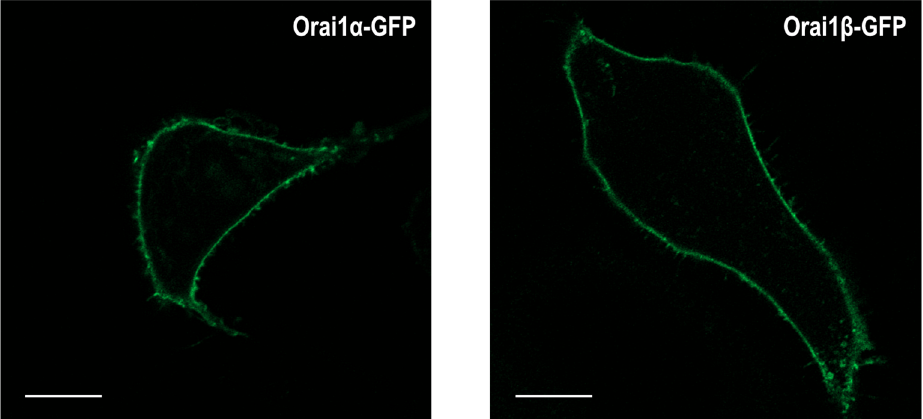
Figure 3. Orai1 α or Orai1 β subcellular location. Representative confocal images of Orai1 α -GFP or Orai1 β -GFP expressed in Orai1-KO HEK-293 cells. Scale bar: 10 µm.